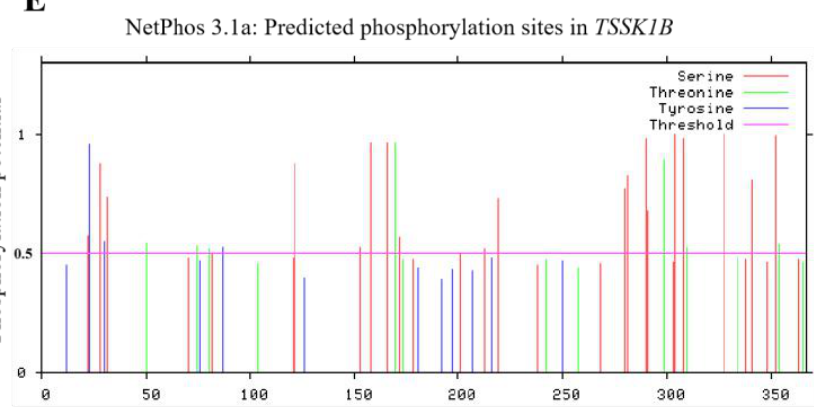
Figure 3. The physicochemical properties of predicted protein coding by TSSK1B gene. ( A ) The predicted secondary structure of protein encoded by TSSK1B gene. Blue line, alpha helix; green line, beta-turn; red line, extended strand; orange line, random coil. ( B ) The predicted tertiary structure of protein. ( C ) The predicted hydrophobicity profile of protein encoded by TSSK1B gene. Hydrophobic: The mean hydrophobicity of each position is more than 0. Hydrophilic: The mean hydrophobicity of each position is less than 0. ( D ) The transmembrane structure of protein coding by TSSK1B gene. The square frame represents the position transmembrane site. ( E ) The phosphorylation sites analysis of TSSK1B. The prediction scores above 0.5 indicate positive